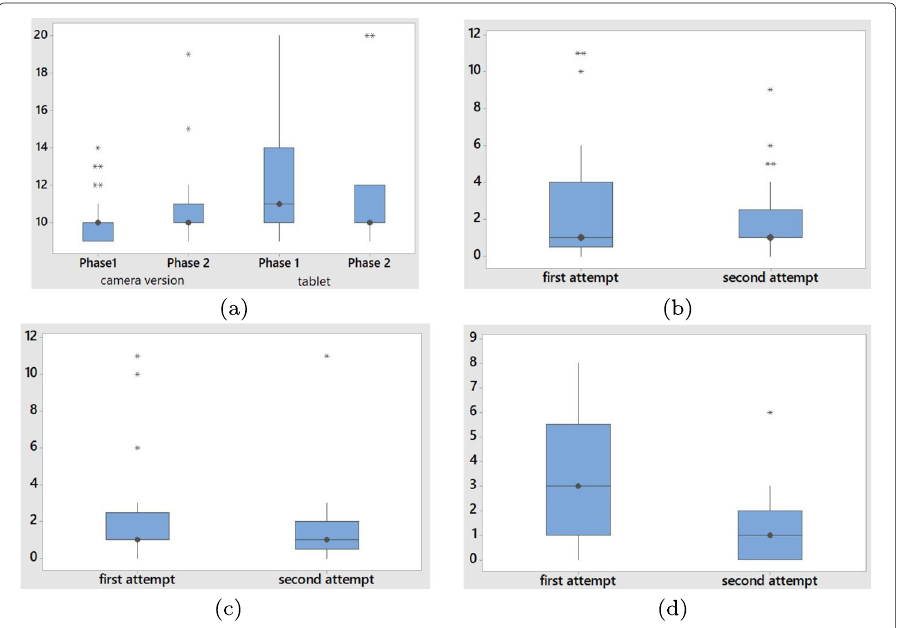
Fig. 4 Number of movements used to achieve the goal of the phases. a Number of Movements. b Additional movements - Phase 1. c Additional movements - Phase 2. d Additional movements - Phase